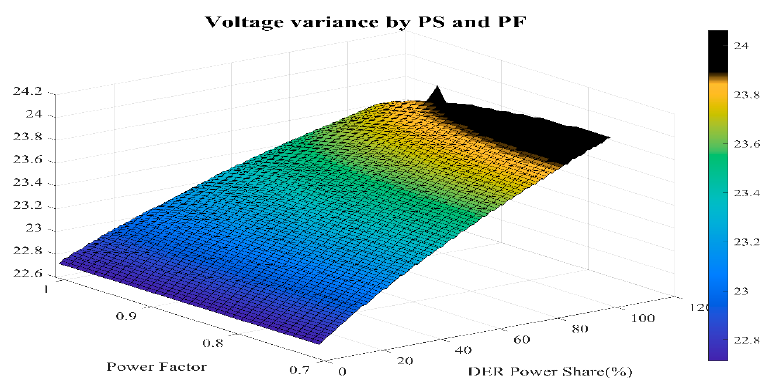
Figure 11. The overall flow of model